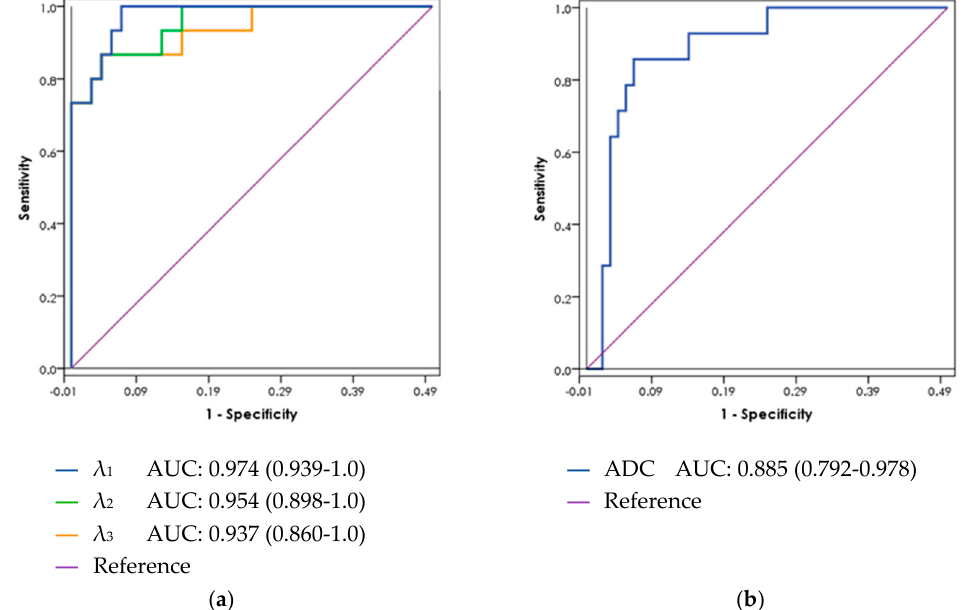
Figure 3. ROC curves for ( a ) DTI and ( b ) DWI metrics in the peripheral zones. ADC: apparent diffusion coefficient; AUC: area under the curve; DTI: diffusion tensor imaging; DWI: diffusion weighted imaging; PCa: prostate cancer; ROC: receiver operating characteristic.